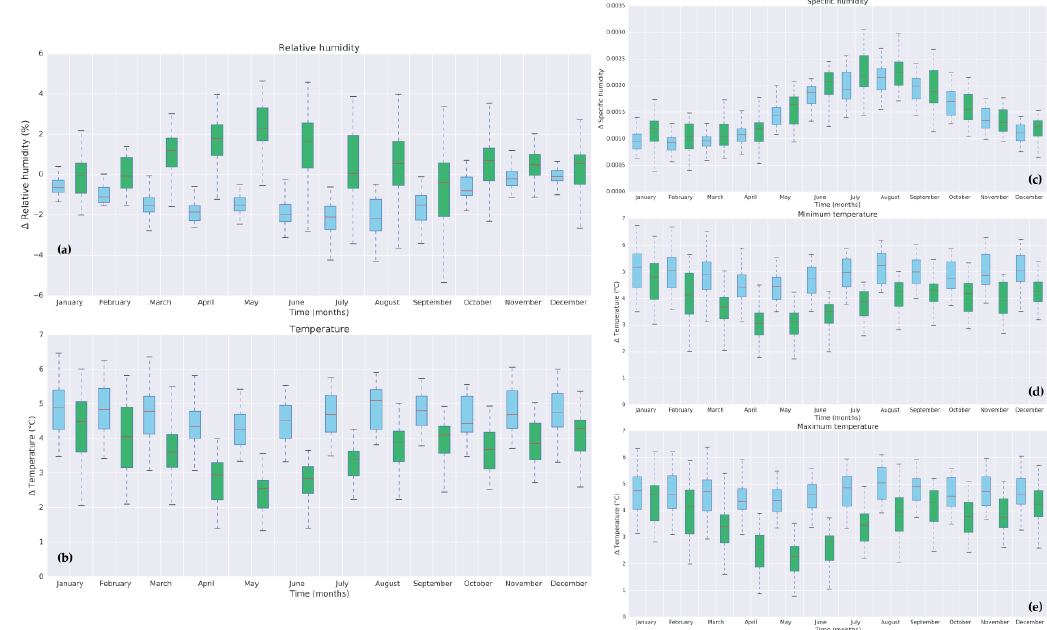
Figure 7. Mean monthly change for each variable under climate change conditions, comparing 1971 – 2000 to 2070 – 2099 for Berlin (grey-blue) and its surroundings (green) for ( a ) RH, (b ) temperature, ( c ) SH, ( d ) minimum temperature, and ( e ) maximum temperature for RCP 8.5. The multi-model median (red line), quartiles (Q1: 25% and Q3: 75%) and whiskers, including interquartile range (IQR) (1.5 × IQR (IQR = Q3 − Q1)) indicate the model spread.